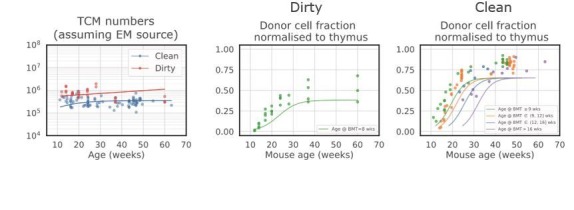
Best fit model in which CM cells are fed exclusively by EM cells.The model underestimates the accumulation of CM donor chimerism, as it is constrained by the lower chimerism of the upstream EM cells.